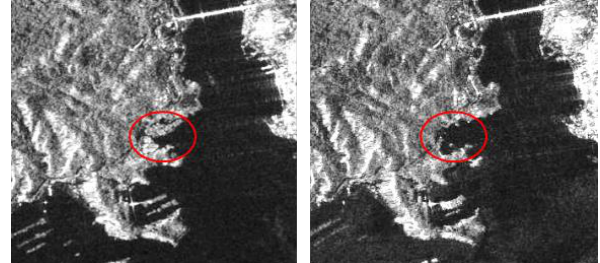
Figure 6. The driftwoods in bay of Hiroshima Pref., Japan from comparison of the two HH amplitude images acquired after (July 21, 2018, left) and before (Apr. 19, 2015, right) due to heavy rain. crater (upper) and Pu'u 'O'o crater (lower) on May 12 and Jan.